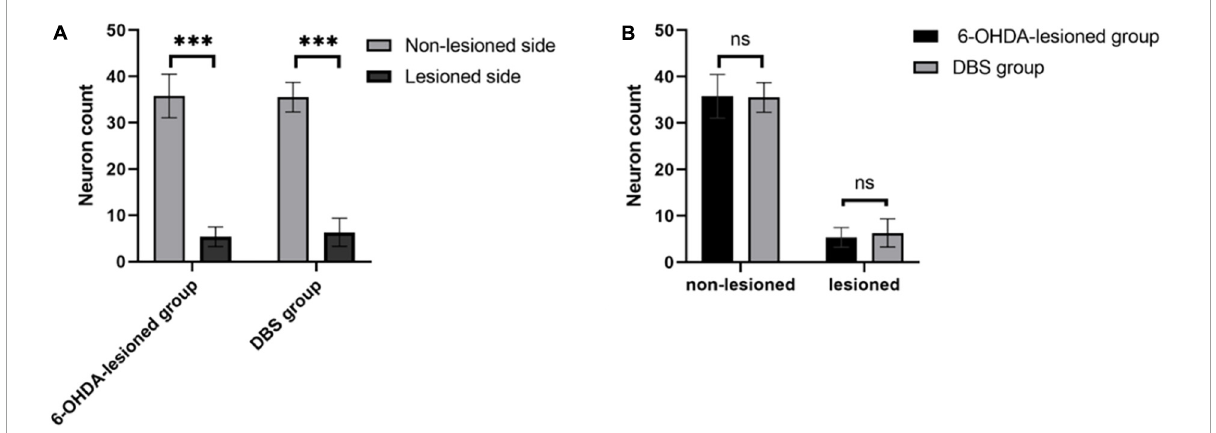
FIGURE6 Counts of TH + neurons in the SNc of rats in the 6-OHDA-lesioned group and the DBS group. (A) Comparison of the number of neurons in the non-lesioned and lesioned SNc in each group. (B) Comparison of the number of neurons in the non-lesioned and lesioned SNc between two groups. *** p <